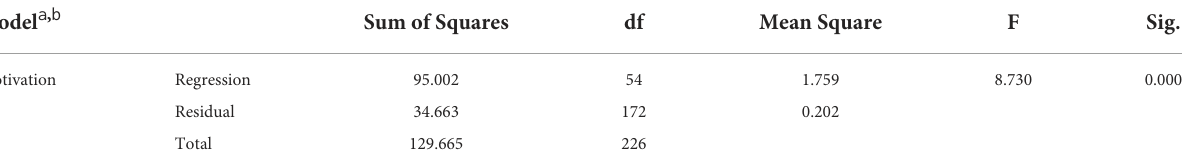
TABLE 3 ANOVA table on motivation.